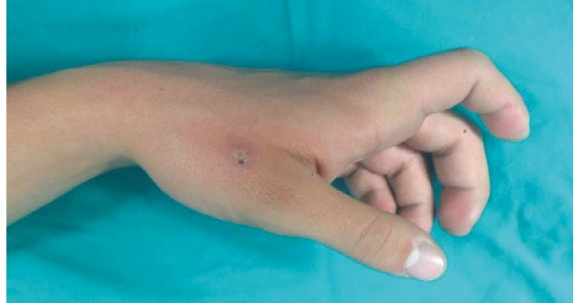
Figure 1: Deformity in hyperextension of the MCP index joint with prominence of the 2nd metacarpal head.